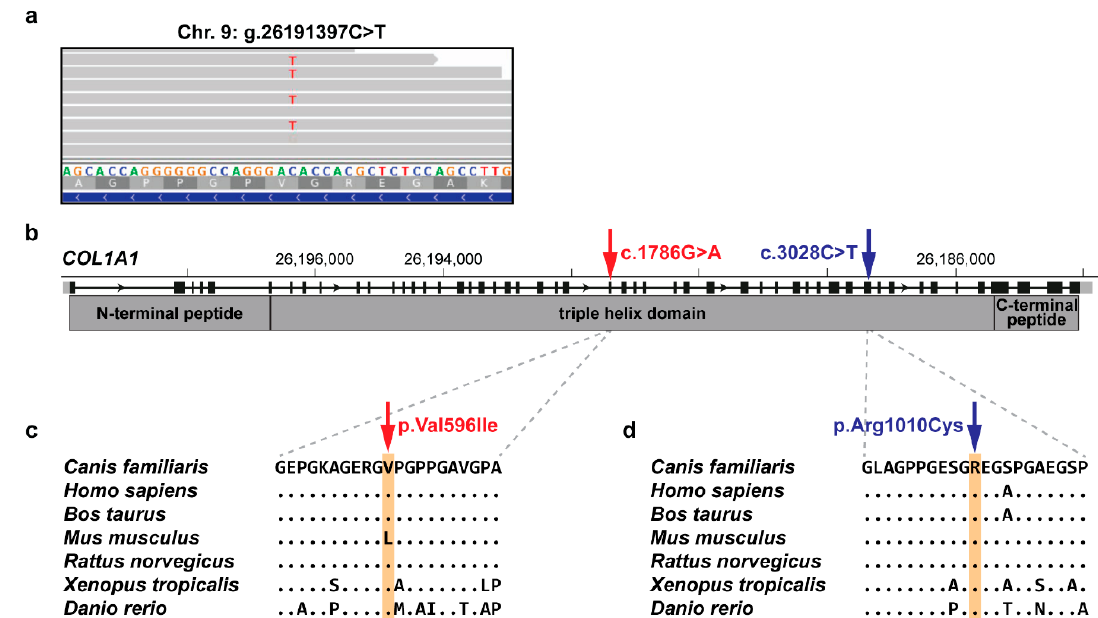
Figure 2. Characterization of the identified functional candidate variant in COL1A1 in the CMO-a ff ected Australian Terrier. ( a ) Integrative genomics viewer (IGV) snapshot showing the heterozygous missense candidate variant (NC_006591.3:g.26191397C > T). ( b ) Schematic representation of COL1A1 indicating the c.1786G > A variant location in exon 26 (red) and the previously described human variant (position with respect to the canine COL1A1 ) in exon 41 (blue) encoding the triple helix domain. Note that the canine COL1A1 gene is annotated on the reverse complementary strand. ( c ) Multispecies protein alignment of the canine CMO-associated missense variant identified herein (red). ( d ) Multispecies protein alignment of the human disease-causing missense variant (blue) [3] with respect to the canine COL1A1 position.